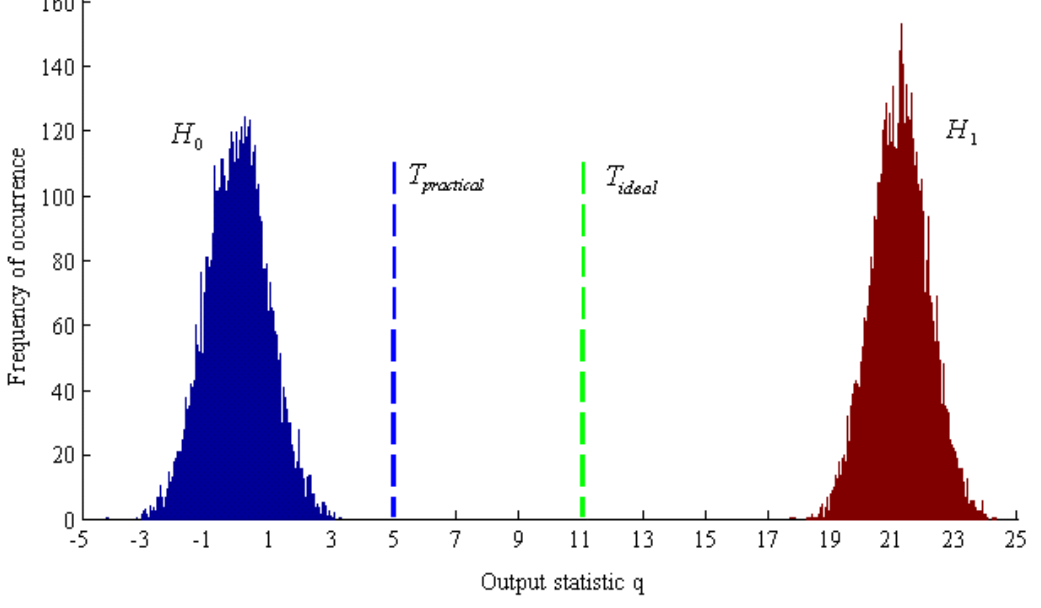
Figure 3. Distributions of the variable q under the hypothesis H the reference image “Lena” with the ideal (dashed green line) and practical (dashed blue line) acceptance